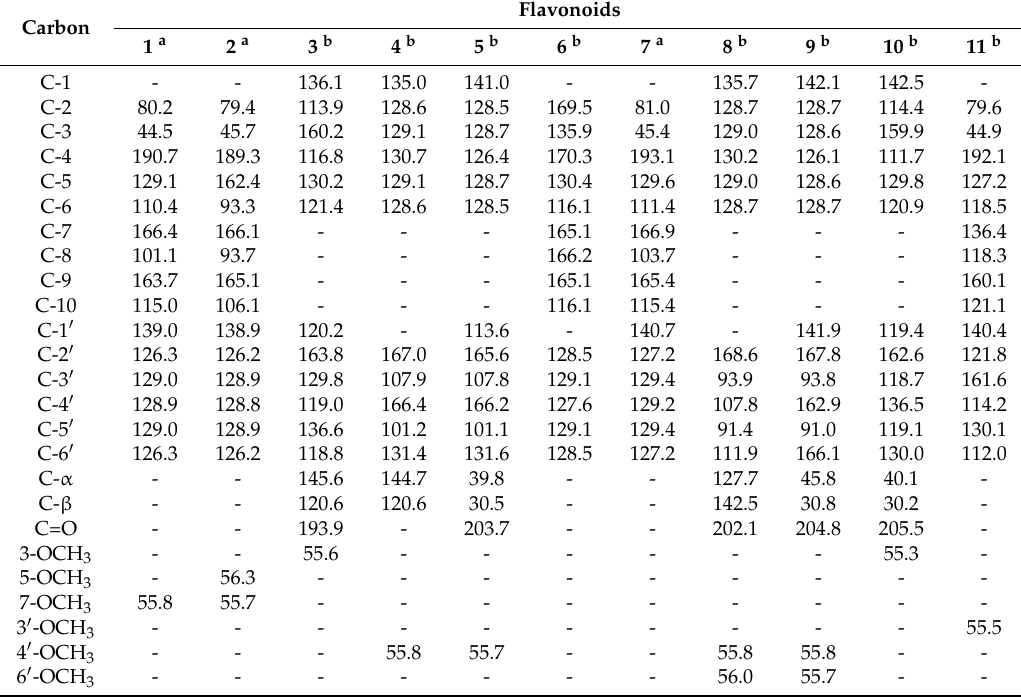
Table 3. 13 C-NMR chemical shifts ( δ ) of flavonoids 1 to 11 (Supplementary Materials).